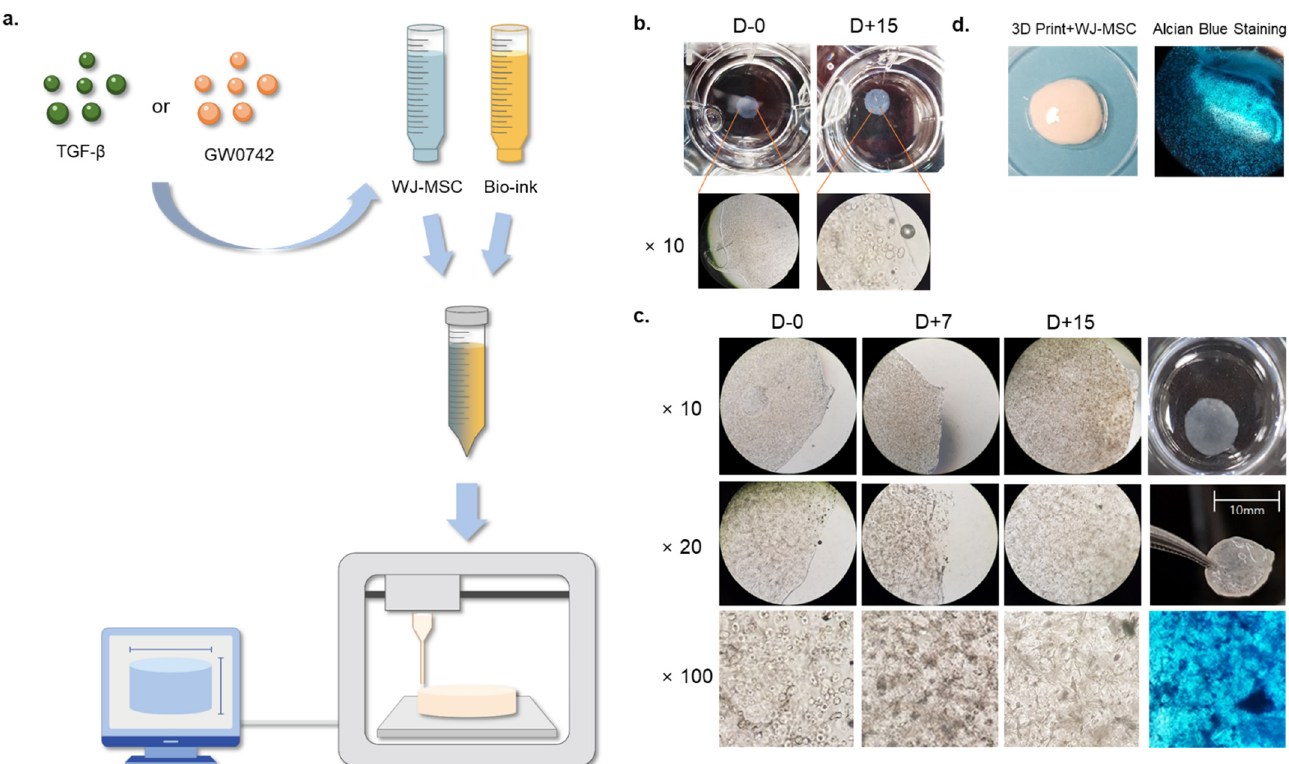
Figure 1. Generation and observation of cartilage-implantable bio-printed scaffolds. ( a ) Schematic showing a generation of the MSC scaffold with the presence or absence of TGF- β or GW0742; ( b ) representative image of macroscopic and microscopic observations of bio-printed scaffolds on day 0 and day 15; ( c ) representative image of microscopic observations of bio-printed scaffolds on days 0, 7, and 15, with alcian blue staining of chondrogenic differentiation on day 15; and ( d ) representative image of bio-printed scaffold and alcian blue staining after chondrogenesis.